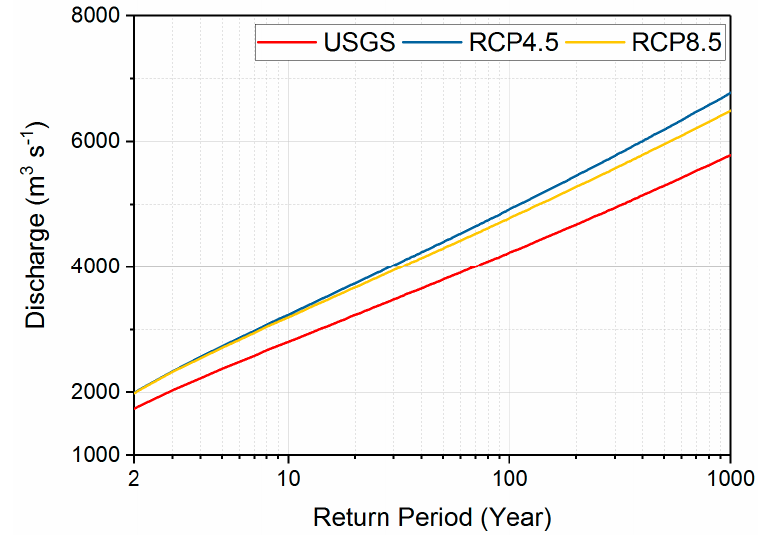
Figure 6. The frequency distribution of annual peak flow with two combined periods (RCP4.5 and RCP8.5 period 1 and 2) and for USGS instantaneous observations using the Bulletin 17C method. Table 3. The results of the Mann-Kendall test for data non-stationarity on annual extreme flows. Time Period p -Value for Upward Trend p -Value for Downward Trend Stationarity Outcome Historic 0.08 0.92 Stationary 0.81 0.19 Stationary